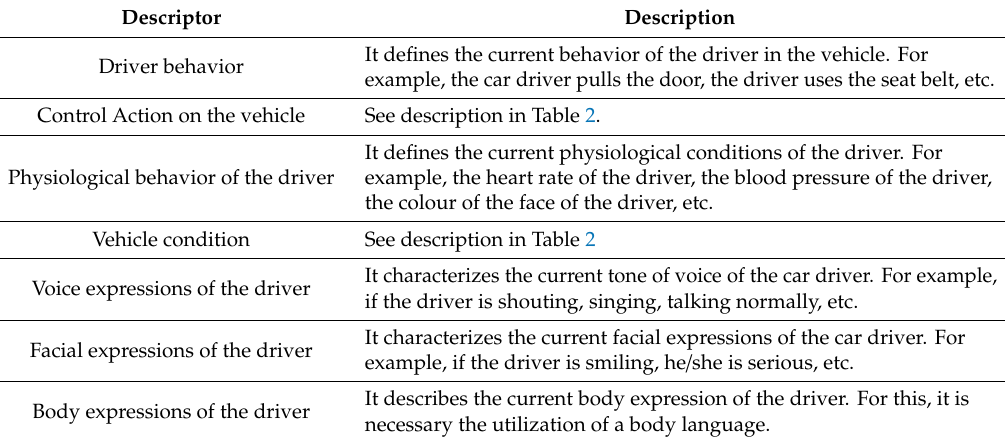
Table 3. Descriptors of the pattern of the emotions of the